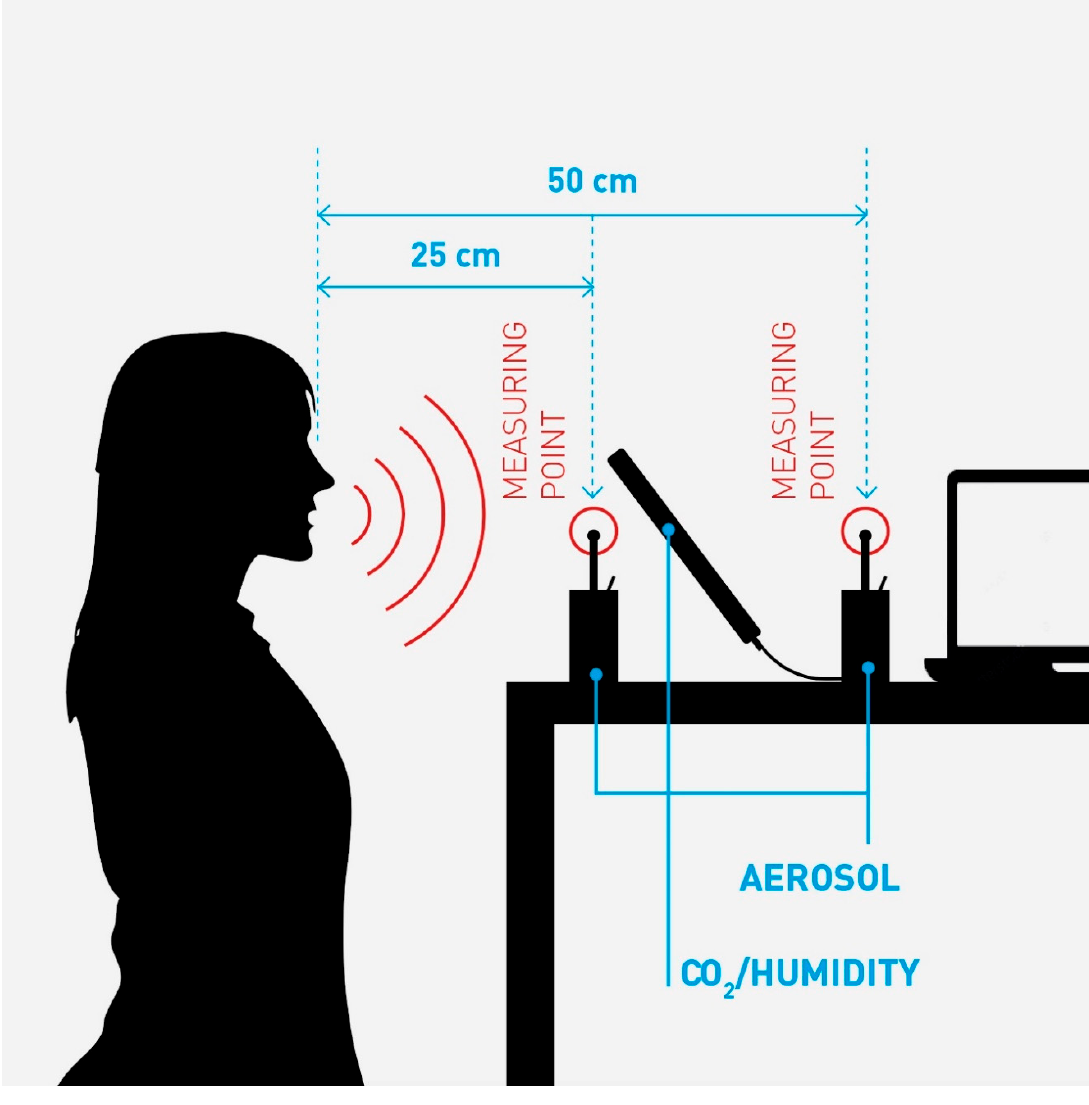
Figure 1. Schematic picture of the sampling set up.